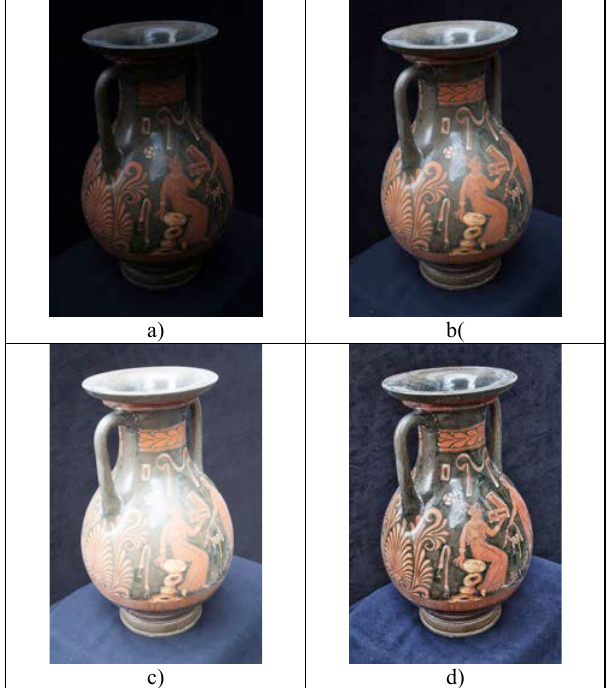
Figure 7. Canonical HDR processing with 3 raw shots at different exposures: a) -2 stops; b) right exposure; c) +2 stops; d) tone mapping of the resulting HDR image.